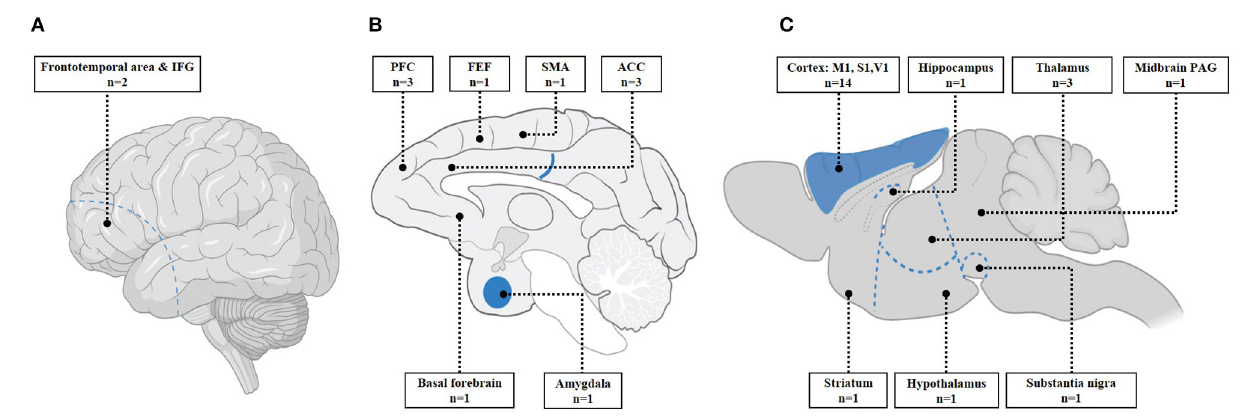
FIGURE 2 | Stimulated regions; (A) left view of human brain; (B) midsagittal view of macaque brain; (C) midsagittal view of mice brain. This image displays targeted regions of mice studies and also includes one sheep study that stimulated at M1 and thalamus. IFG, inferior frontal gyrus; PFC, prefrontal cortex; FEF, frontal eye fields; SMA, supplementary motor area; ACC, anterior cingulate cortex; M1, primary motor cortex; S1, Somatosensory cortex; V1, visual cortex; PAG, periaqueductal gray. (A,C) was adapted from “human and mice brain icons,” by BioRender.com (2020). Retrieved from: https://app.biorender.com/biorender-templates. (B) was adapted from Raper et al.